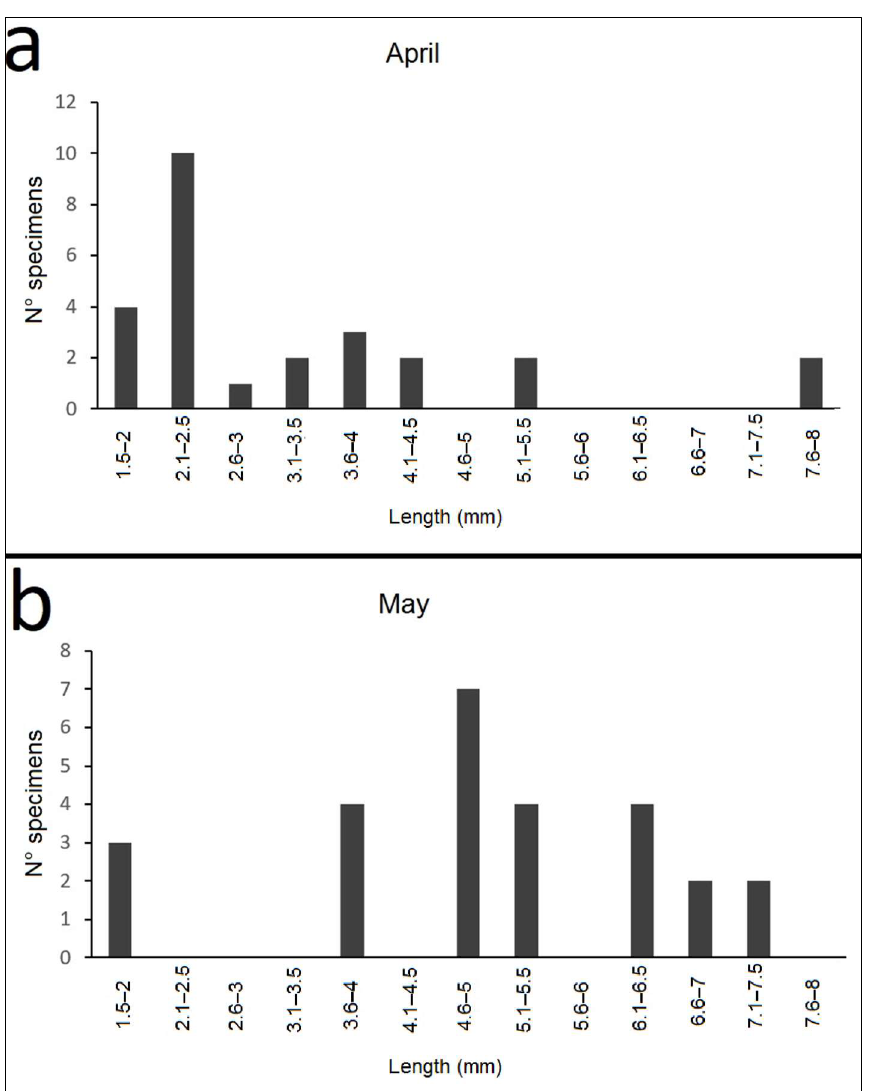
Figure 6. Number of specimens of Nebrioporus ceresyi , both larval and adult, during the year in sites B ( a ) and C ( b ).